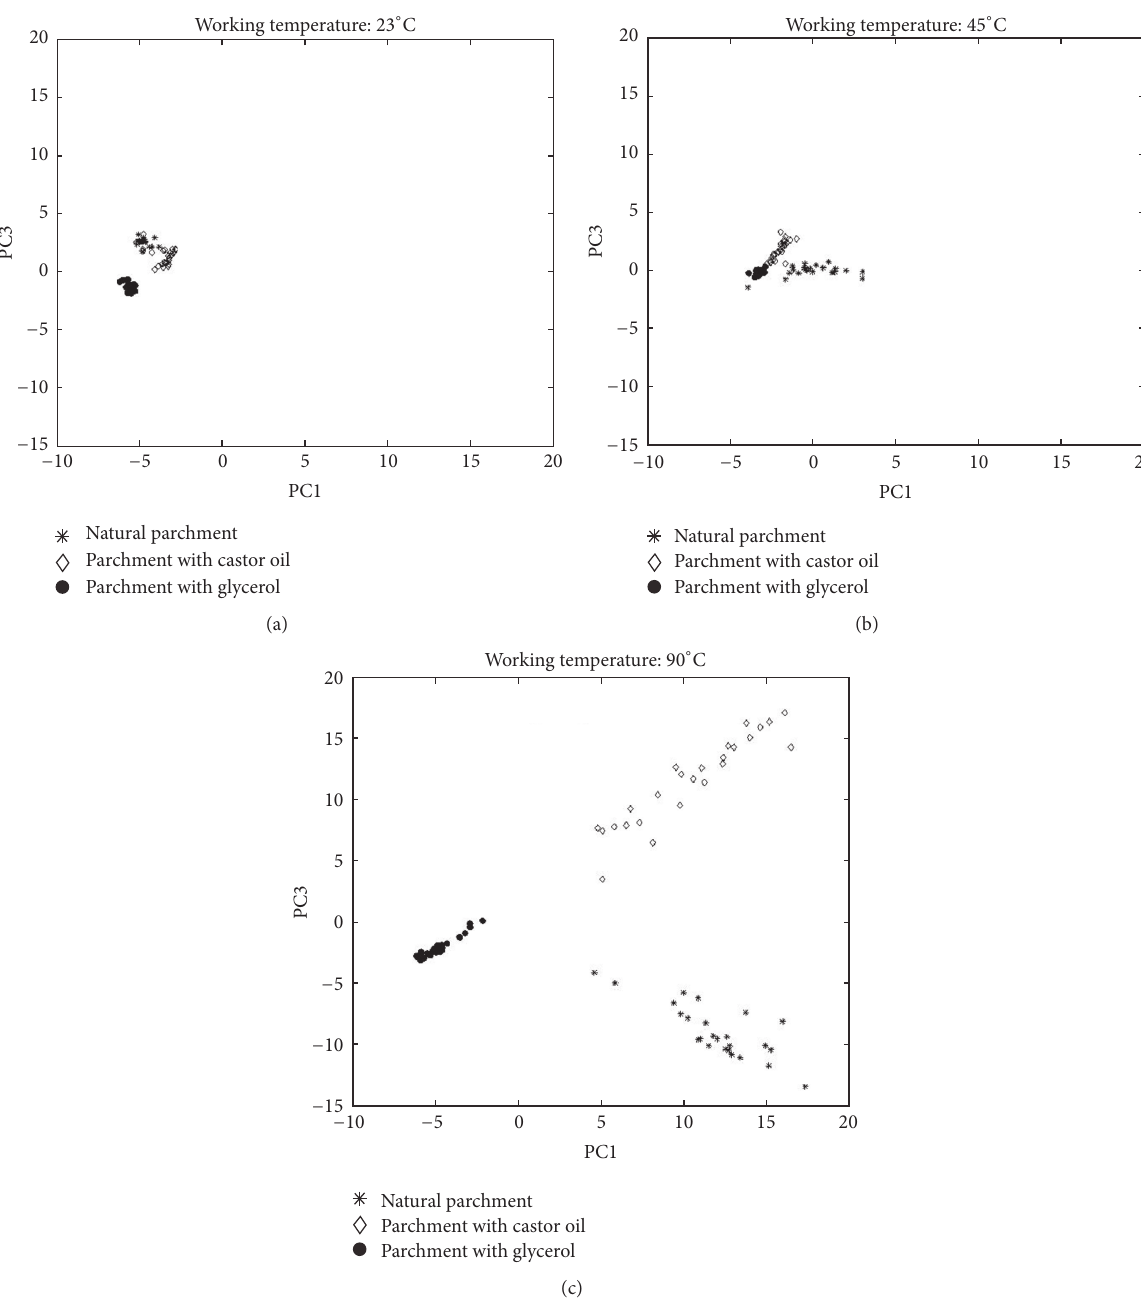
Figure 8: Score plots of PC1 and PC3 for each working temperature and for the 3 different groups of samples.